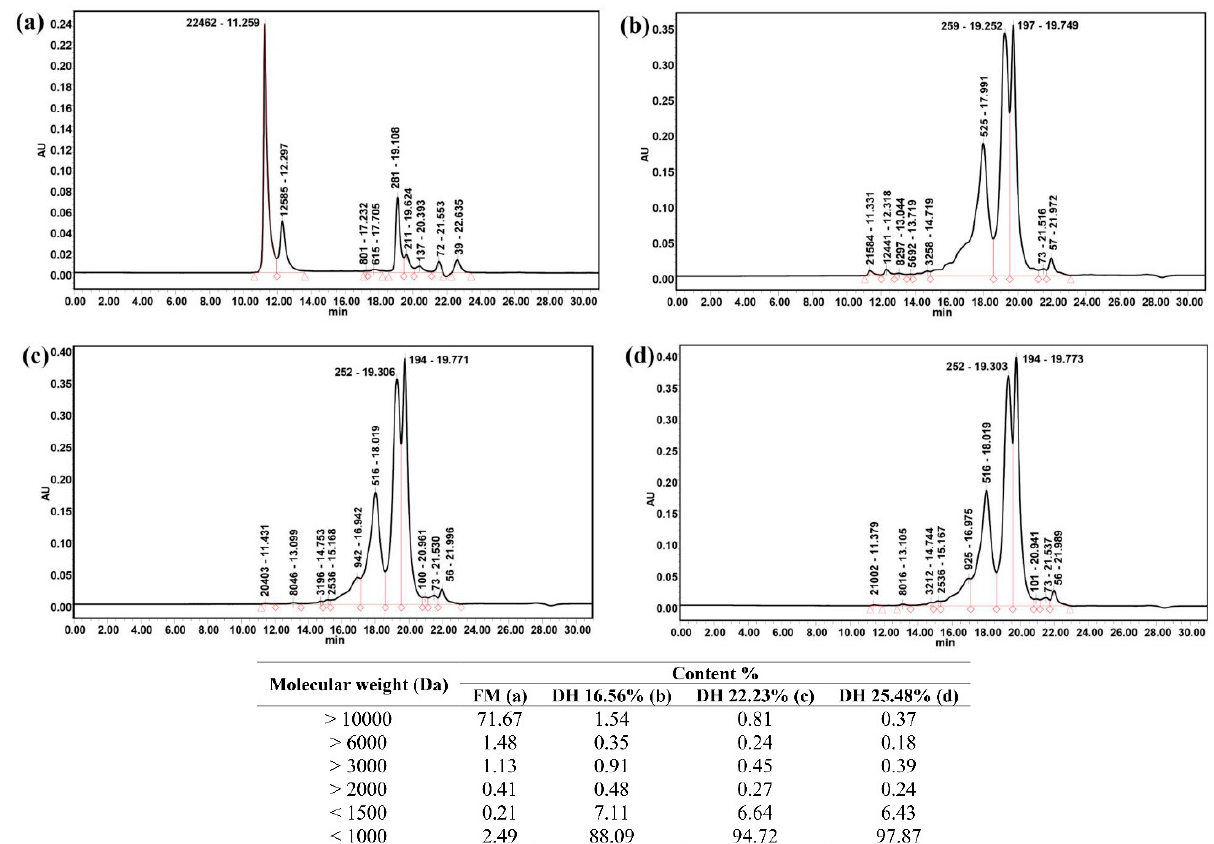
Figure 2. Molecular weight distribution of the fresh and hydrolysate products derived from fish bighead carp using flavourzyme protease under three different degrees of hydrolysis: ( a ) fresh sample; ( b ) DH 16.56% (1 h); ( c ) DH 22.23% (3 h); and ( d ) DH 25.48% (6